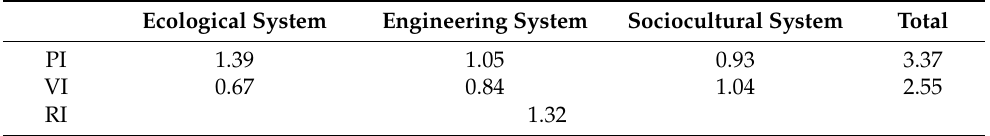
Table 6. Landscape resilience assessment results of Fanhua